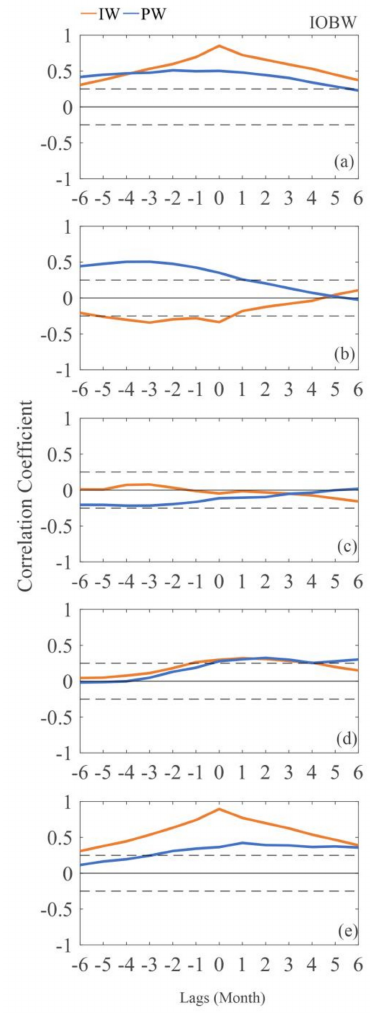
Figure 10. Lead-lag correlations between IOBW and the ( a ) Size variation; ( b ) Zonal center movement; ( c ) Meridional center movement; ( d ) Maximum SST; ( e ) Mean SST of the IW and